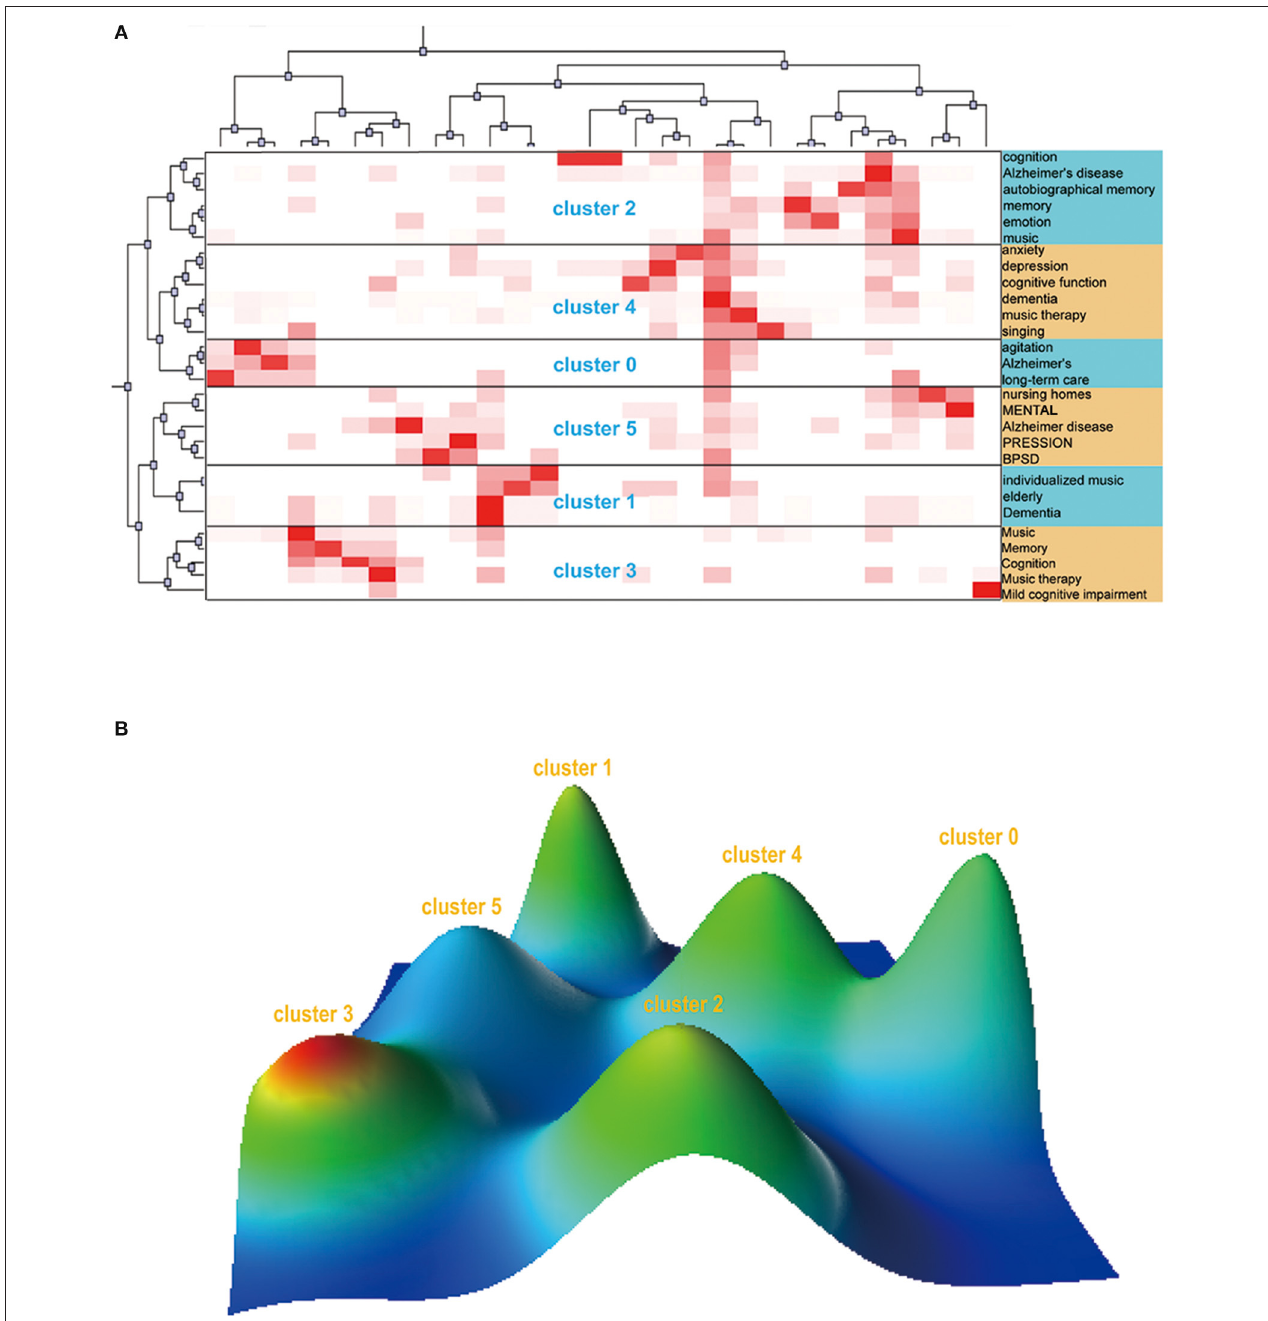
FIGURE 9 | The biclustering result of highly frequent keywords and source articles in the field of music therapy for dementia from 2010 to 2021. (A) Matrix visualization of biclustering of 28 high-frequency keywords and source articles. (B) Mountain visualization of biclustering of 28 high-frequency keywords and source